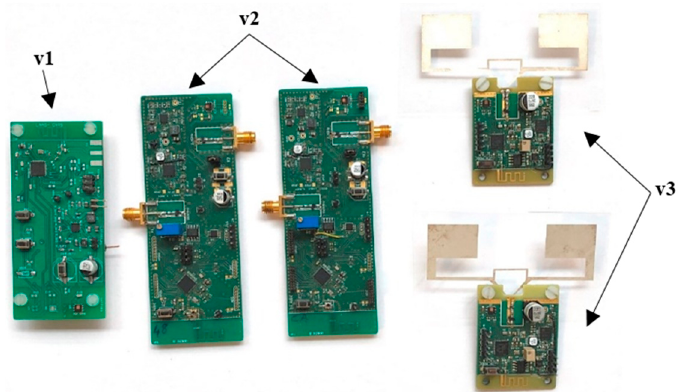
Figure 2. The BLE devices used in our experiments. These devices were designed in the context of the same project; they are different versions of the same product whose hardware and software architectures have evolved over time. Thus, v1 (the board at the left end) refers to the first ever version; v2 (the two boards in the middle) and v3 (the two boards at the right end) refer to the second and third versions, respectively.